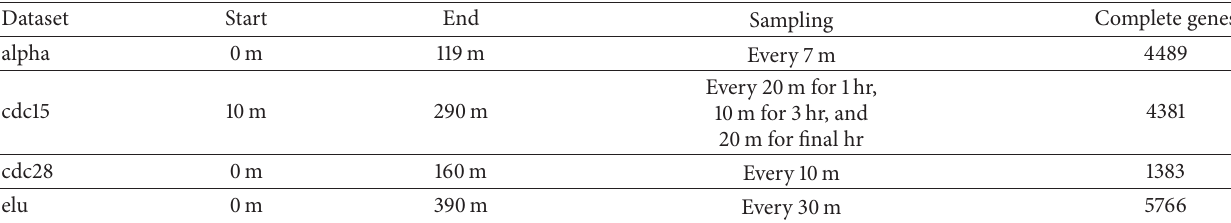
Table 1: Characteristic of Spellman